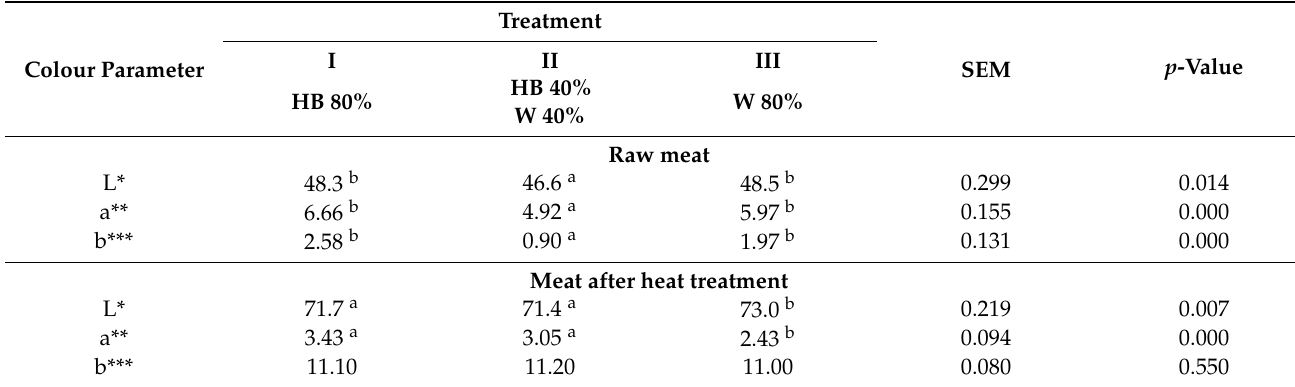
Table 3. Meat colour parameters.